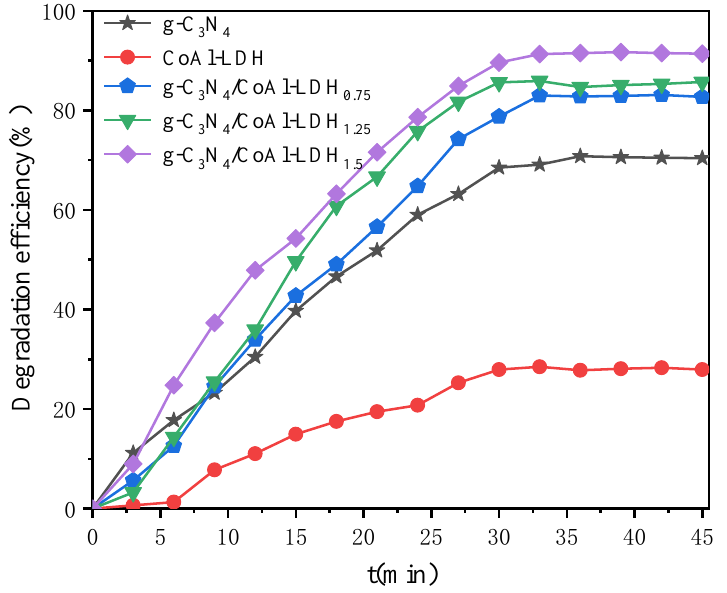
Figure 8. Photocatalytic degradation of NO x by g-C 3 N 4 , CoAl-LDH, and the g-C 3 N 4 /CoAl-LDH nanocomposites. Table 2. Comparison of NO x degradation performances of selected g-C 3 N 4 -based photocatalysts.